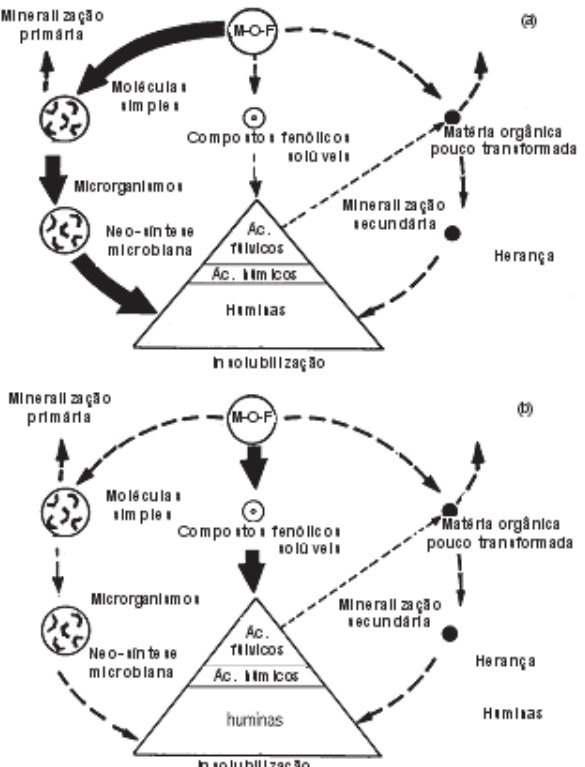
Figura 2. Esquema representativo das vias de humificação. Com adição de glicose a via de humificação favorecida é da neossíntese microbiana de compostos orgânicos rapidamen- te estabilizados como huminas (a); com a adi- ção de raízes de arroz é favorecida a formação de ácidos fúlvicos por reações de policonden- sação (b). MOF = matéria orgânica fresca. (Adaptado de